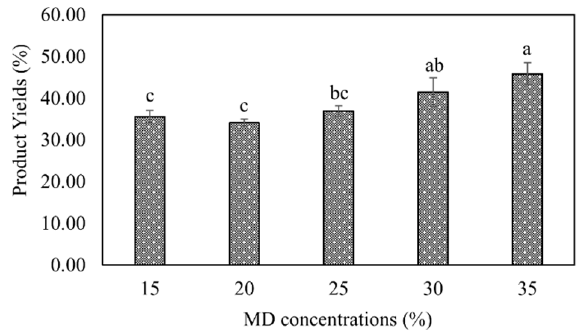
Figure 1. Product yields using different maltodextrin (MD) concentrations into lemon by-product aqueous extracts during spray-drying; Bars followed by different letters are significantly different at P < 0.05, according to the Duncan’s test.